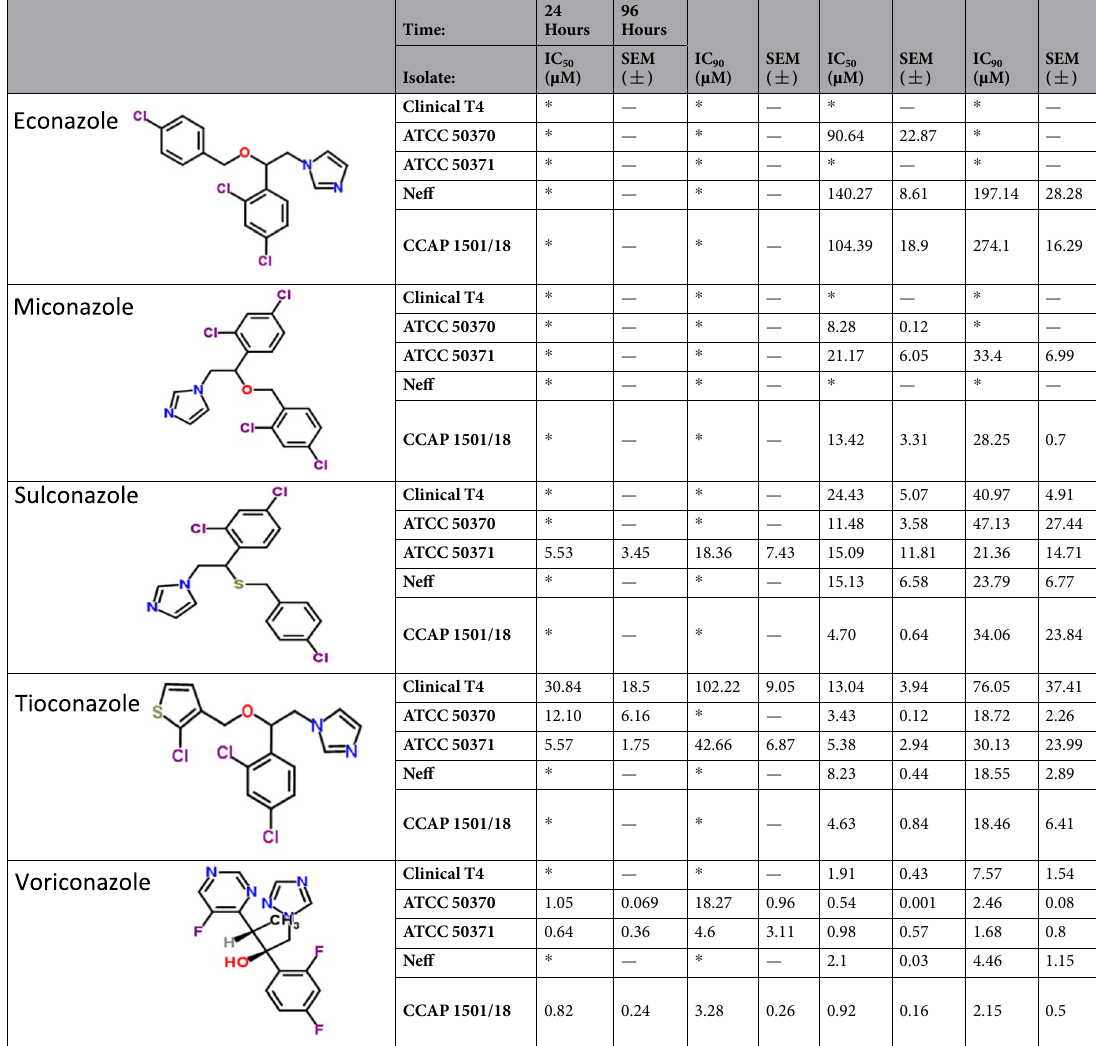
Table 2. IC 50 and IC 90 values for the azoles screened against various Acanthamoeba strains at 24 and 96 hours. * IC 50 or IC 90 value was not consistently obtained within the range of concentrations